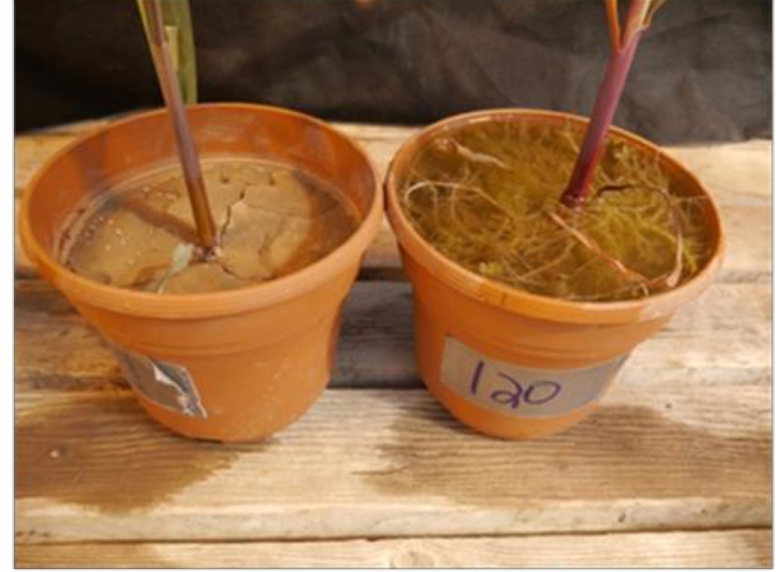
Figure 11. Proliferation of surface roots due to waterlogging (right side) and nonwaterlogged soil (left